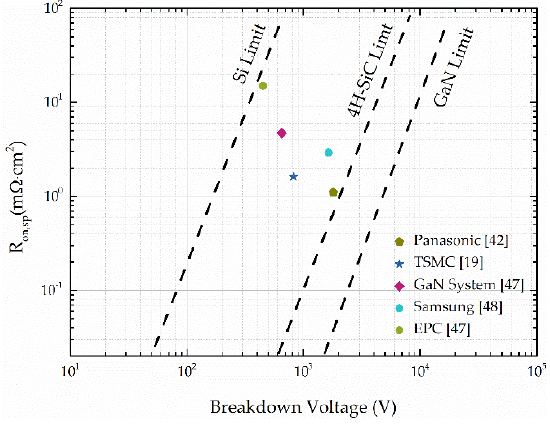
Figure 2. Specific on-resistance versus device breakdown voltage of the p-GaN HEMTs.